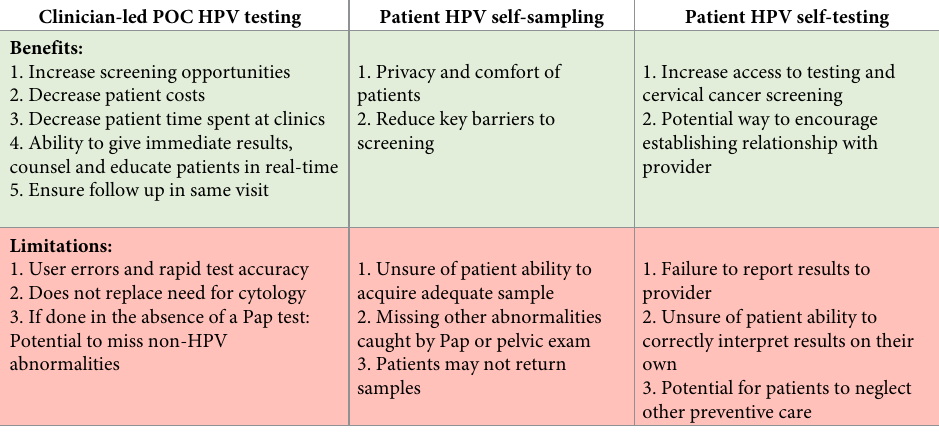
Table 2. Perceived benefits and limitations of rapid testing modalities for cervical cancer